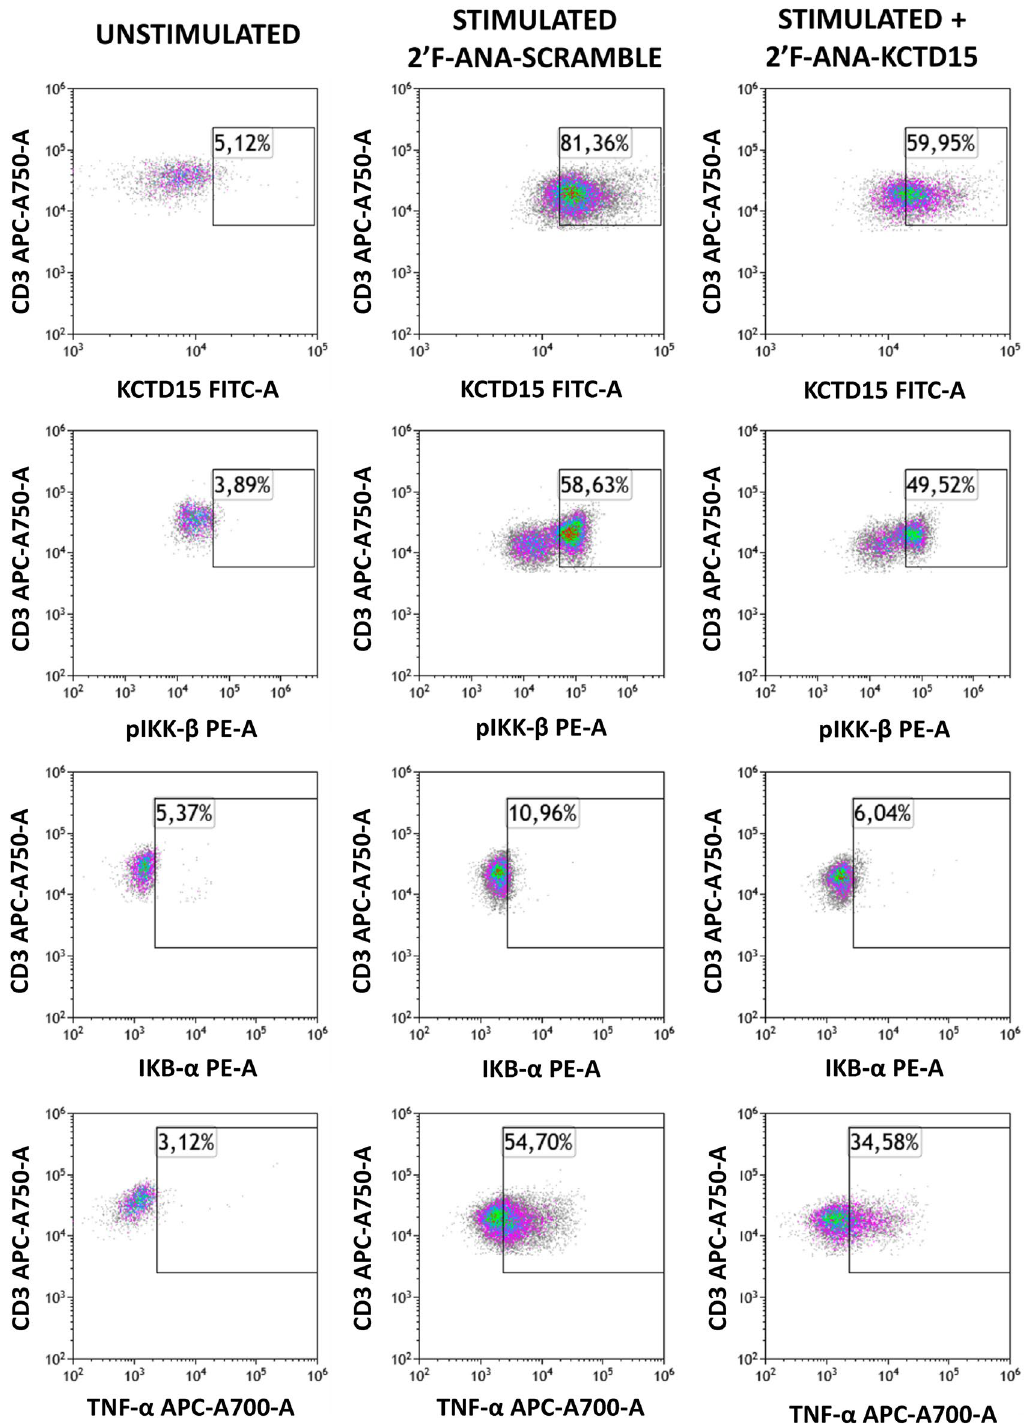
Figure 5. Inhibition of KCTD15 translation impairs TNF-alpha production in PMA/Ionomycin stimulated lymphocytes: density-plot analysis of Unstimulated (left), PMA/Ionomycin stimulated plus 2 ′ F-ANA-Scramble (middle) and 2 ′ F-ANA-KCTD15 (right) PBMCs. Numbers represent the % of the positive cells. Results are representative of two independent